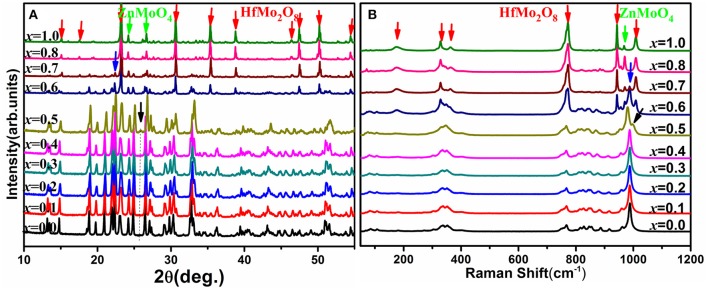
(A) X-ray diffraction patterns of the solid solutions of HfMg1−xZnxMo3O12; (B) Raman spectra of the solid solutions of HfMg1−xZnxMo3O12.